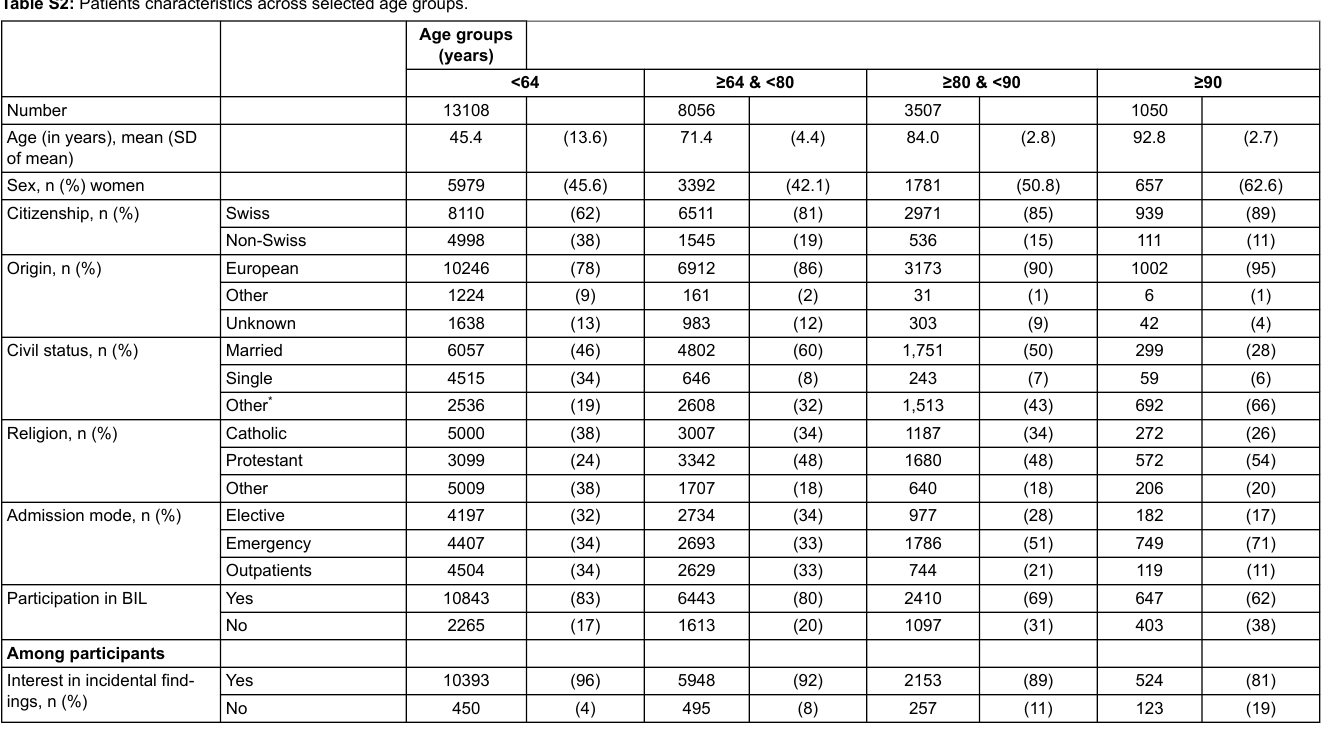
Table S2: Patients characteristics across selected age